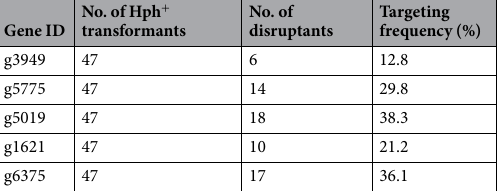
Table 1. Targeted frequency of genes by CRISPR/Cas9 and T-DNA vector